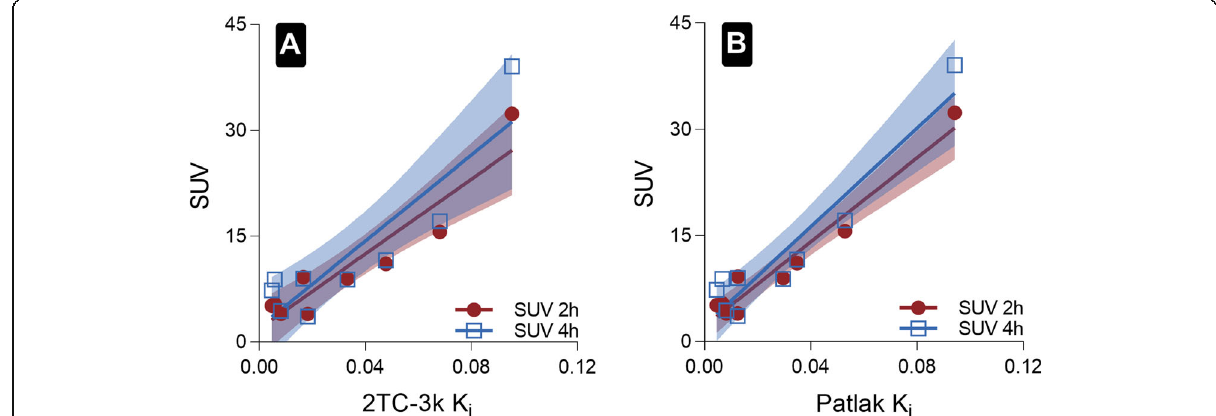
Fig. 5 a 2TC-3k K i correlation with SUV 2 h and SUV 4 h ( R 2 = 0.87, 0.80 respectively, both p < 0.0001). b Patlak K i correlation with SUV 2 h and